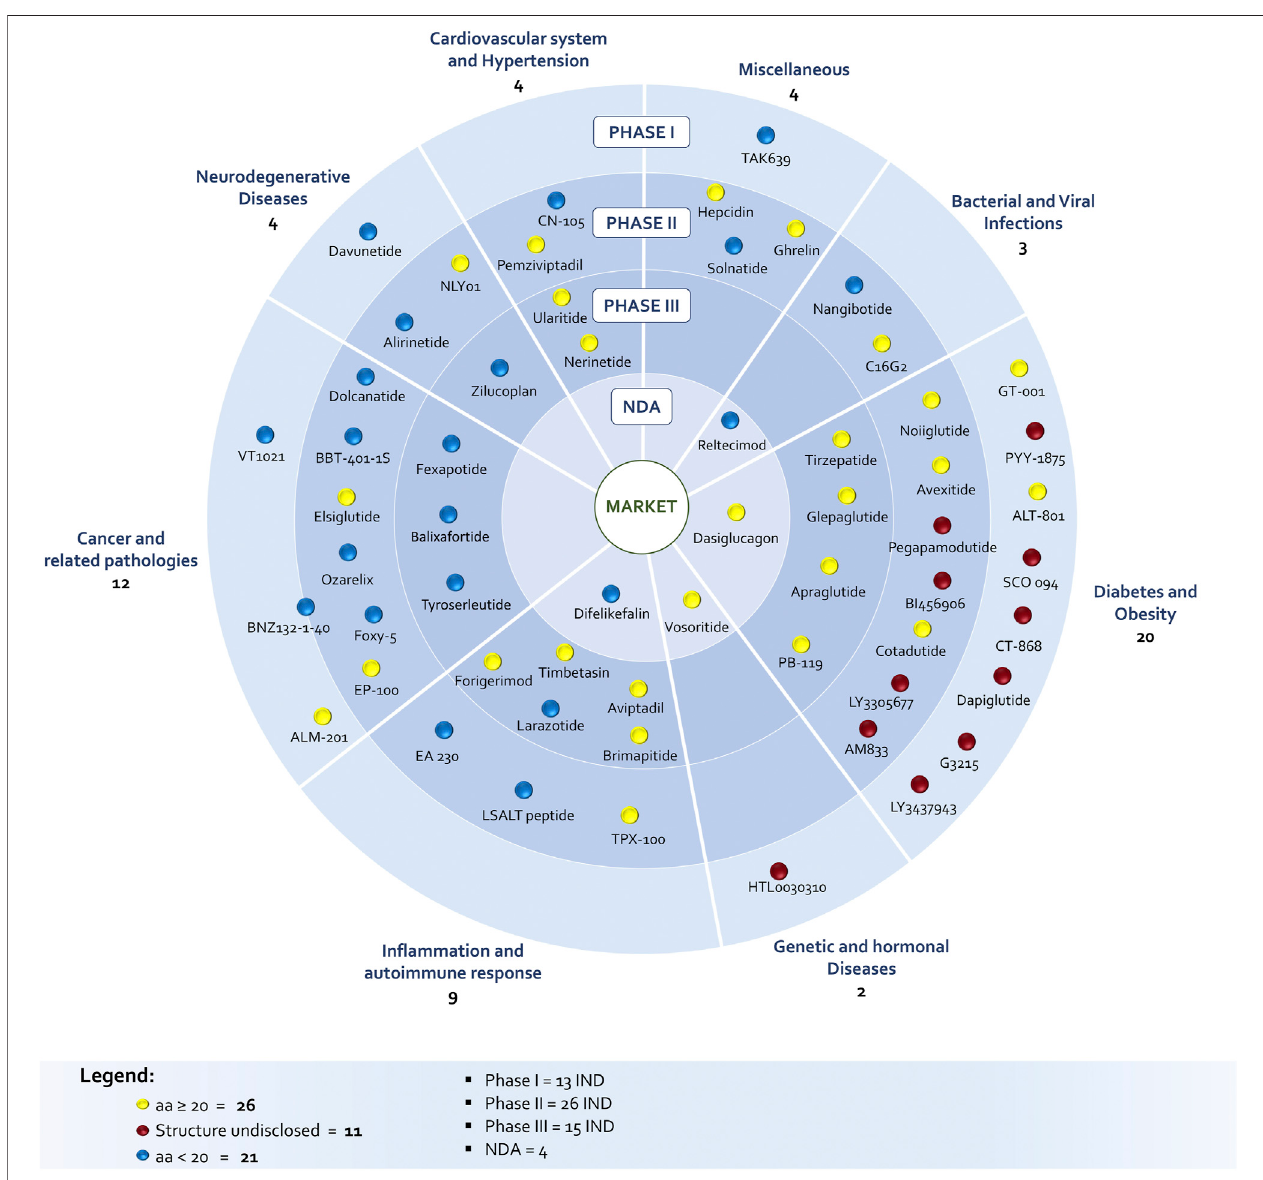
FIGURE 1 | Clinical status of peptide with protein-protein interaction